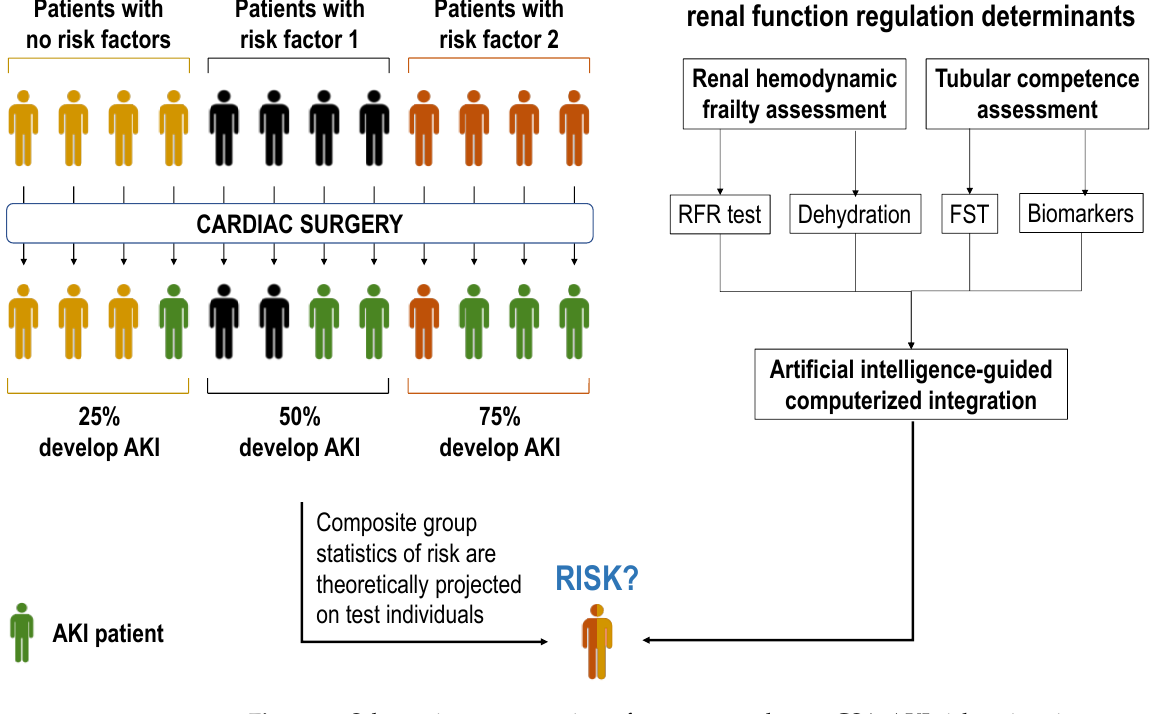
Figure 2. Schematic representation of two approaches to CSA-AKI risk estimation: a traditional, probabilistic approach based on the scoring of risk factors ( left ), and a new, potential approach based on the assessment of the impact of risk factors on the direct determinants of renal function ( right ). AKI, acute kidney injury. FST, furosemide stress test. RFR, renal functional reserve.